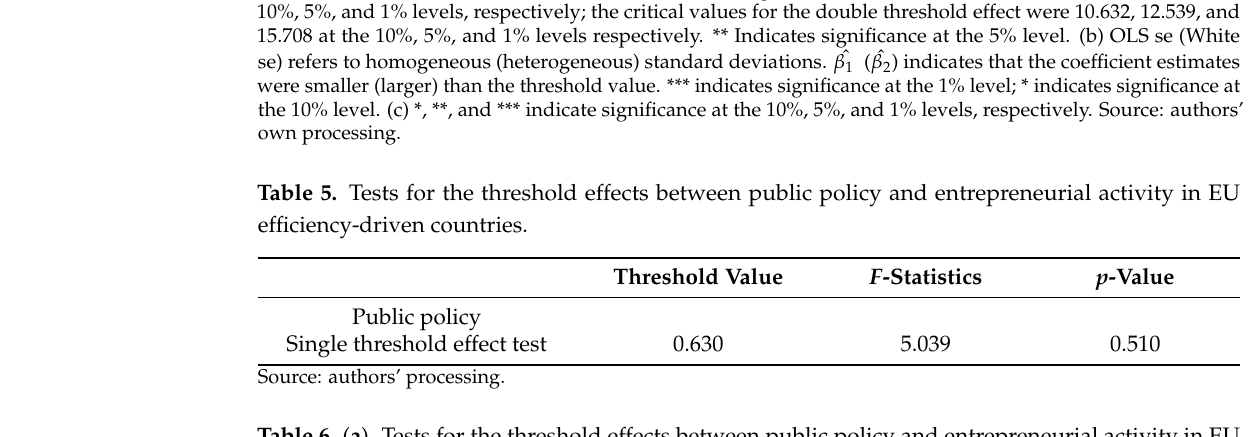
Table 6. ( a ). Tests for the threshold effects between public policy and entrepreneurial activity in EU innovation-driven countries. ( b ). Estimated coefficients of public policy. ( c ). Estimated coefficients of the control